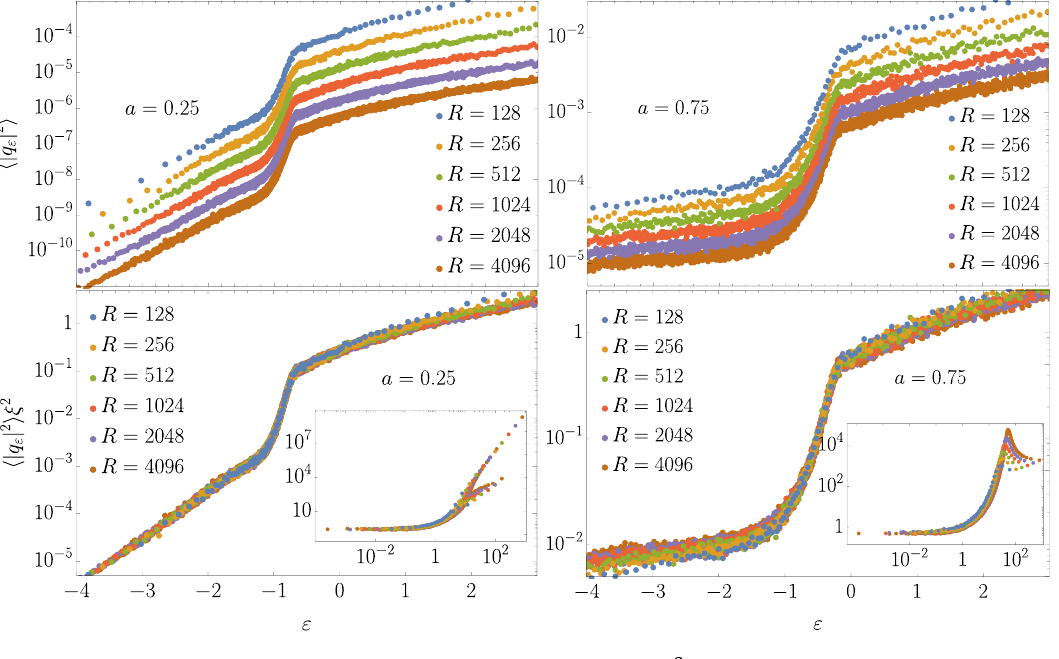
Figure 6: Mean squared effective charge 〈| q (cid:34) ( R ) | 2 〉 versus energy (cid:34) . (Up- per row) energy dependence of 〈| q (cid:34) ( R ) | 2 〉 for several cutoffs (shown in legend) in the vicinity of the DOS maximum. (Lower row) energy dependence of 〈| q (cid:34) ( R ) | 2 〉 ξ 2 ( R ) collapsed by the multiplication by the squared renormalization scale, confirming the analytical result, Eq. (19). (Insets) the same collapse for all positive energies in log- log scale. In all panels the data is averaged over 10 3